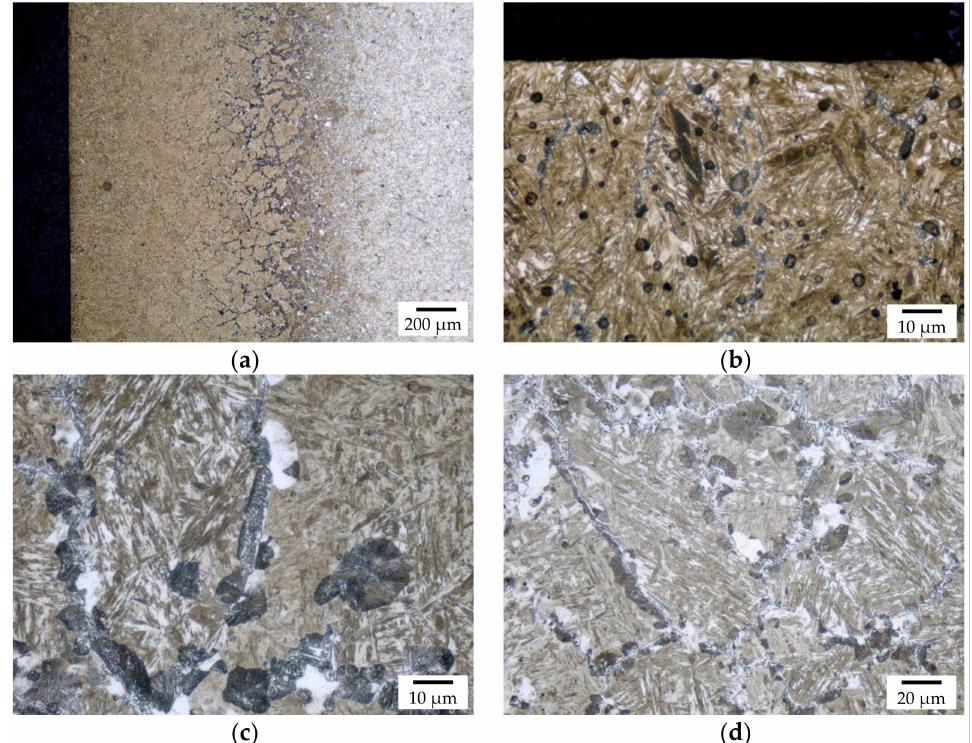
Figure 8. Detailed images of the polished section of the carbonitrided sample without hollow spheres; ( a ) location of the respective position relative to the core, case, and transition zone, ( b ) view of the case, ( c ) transition zone, and ( d ) core.